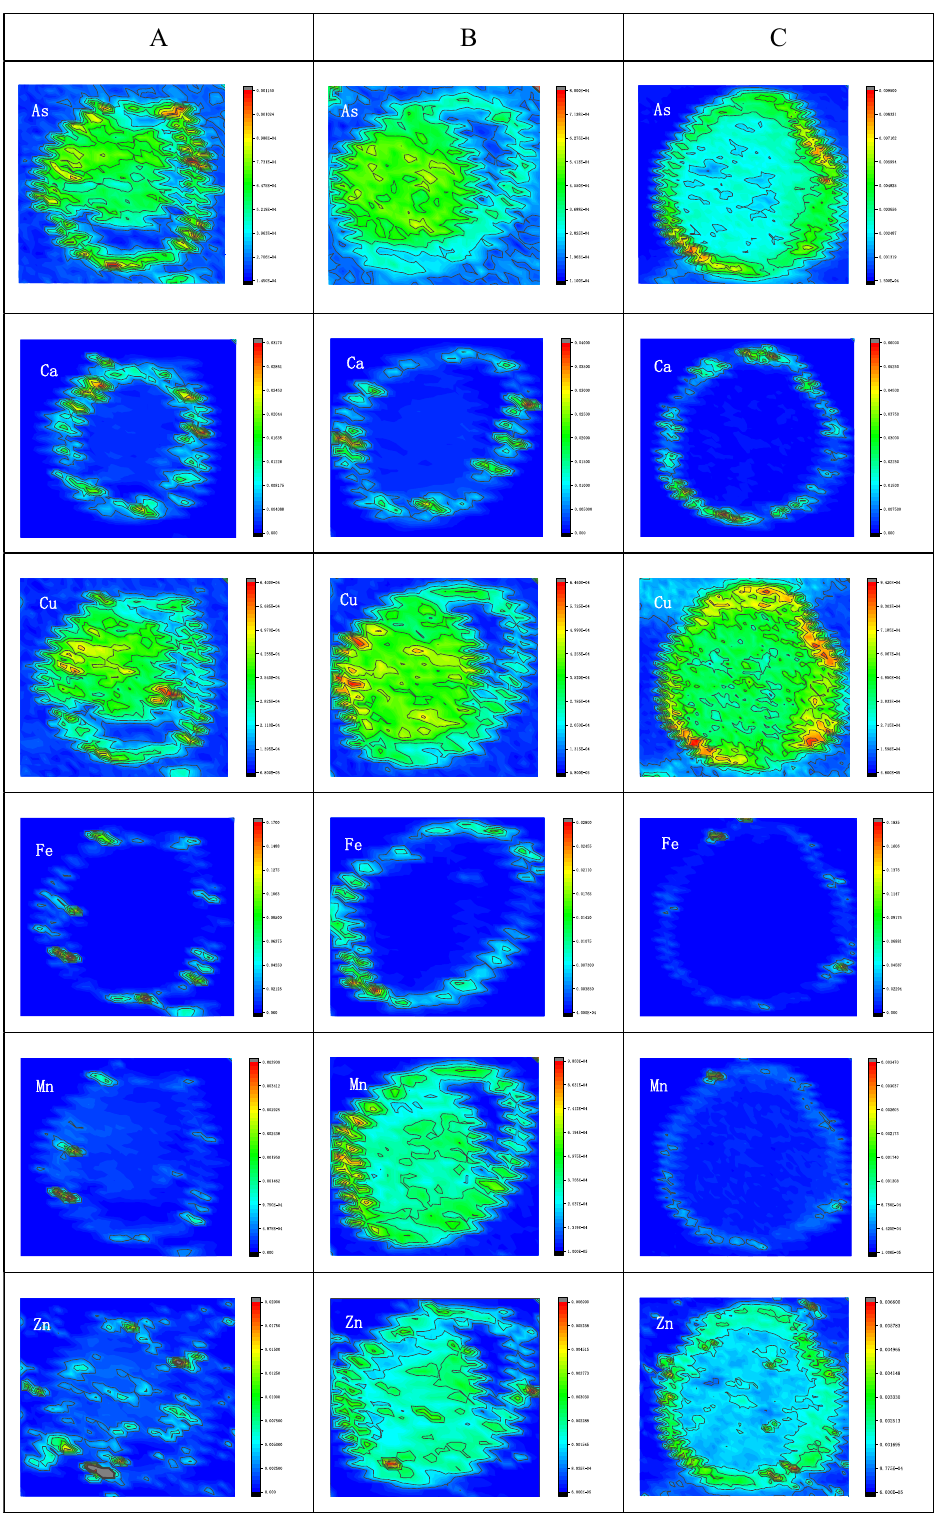
Figure 1: As and other related elements in the root section of honeysuckle μ - XRF distribution. A: 70 mg/L DMA group, B: control group, C: 30 mg/L As ( III )